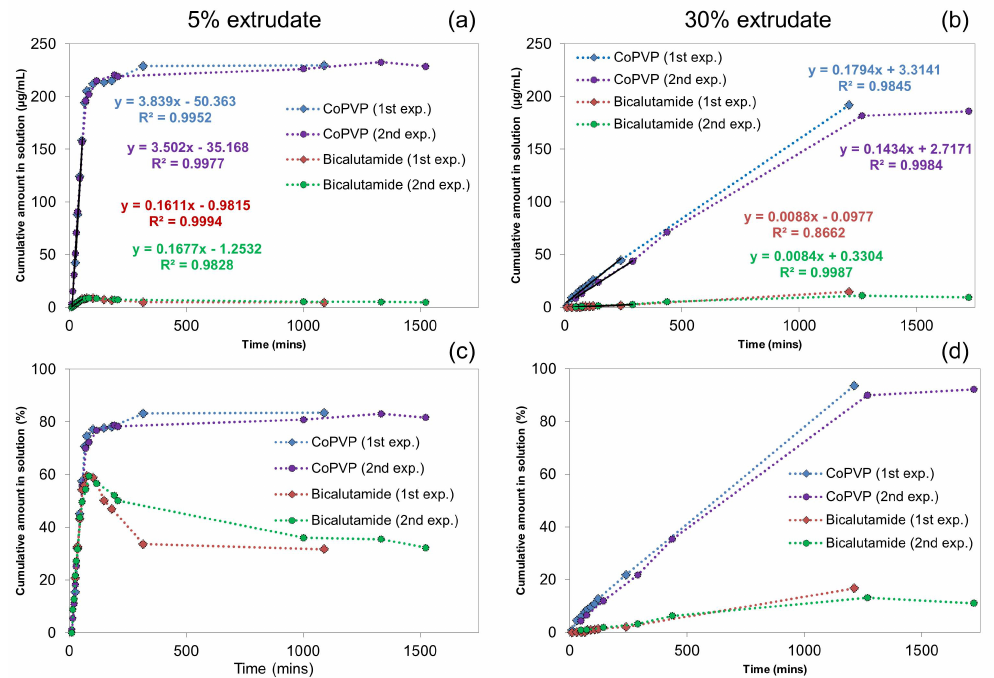
Figure 4. Release profiles obtained from the 1 H-NMR spectra of bicalutamide and coPVP from the 5% and 30%